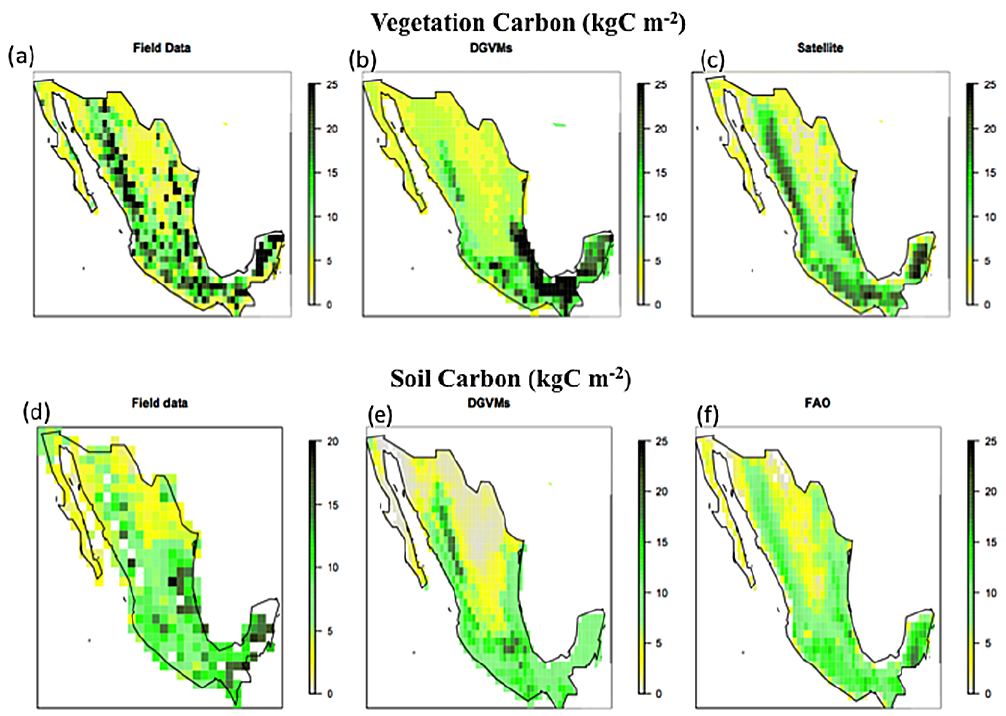
Figure 4. (Top) vegetation stored carbon for three products: field data, DGVMs and satellite (kgCm − 2 ) . (Bottom) soil stored carbon for three products: field data, DGVMs and FAO estimates based on multiple data sets (kgCm − 2 ) . Mean for the time period 2000–2005.